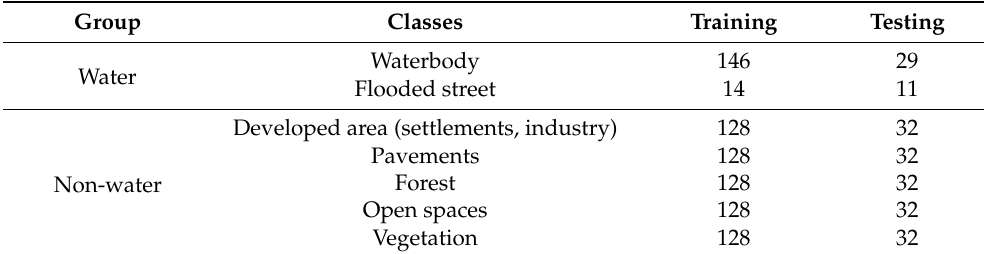
Table 3. Description of model training and testing datasets. Group